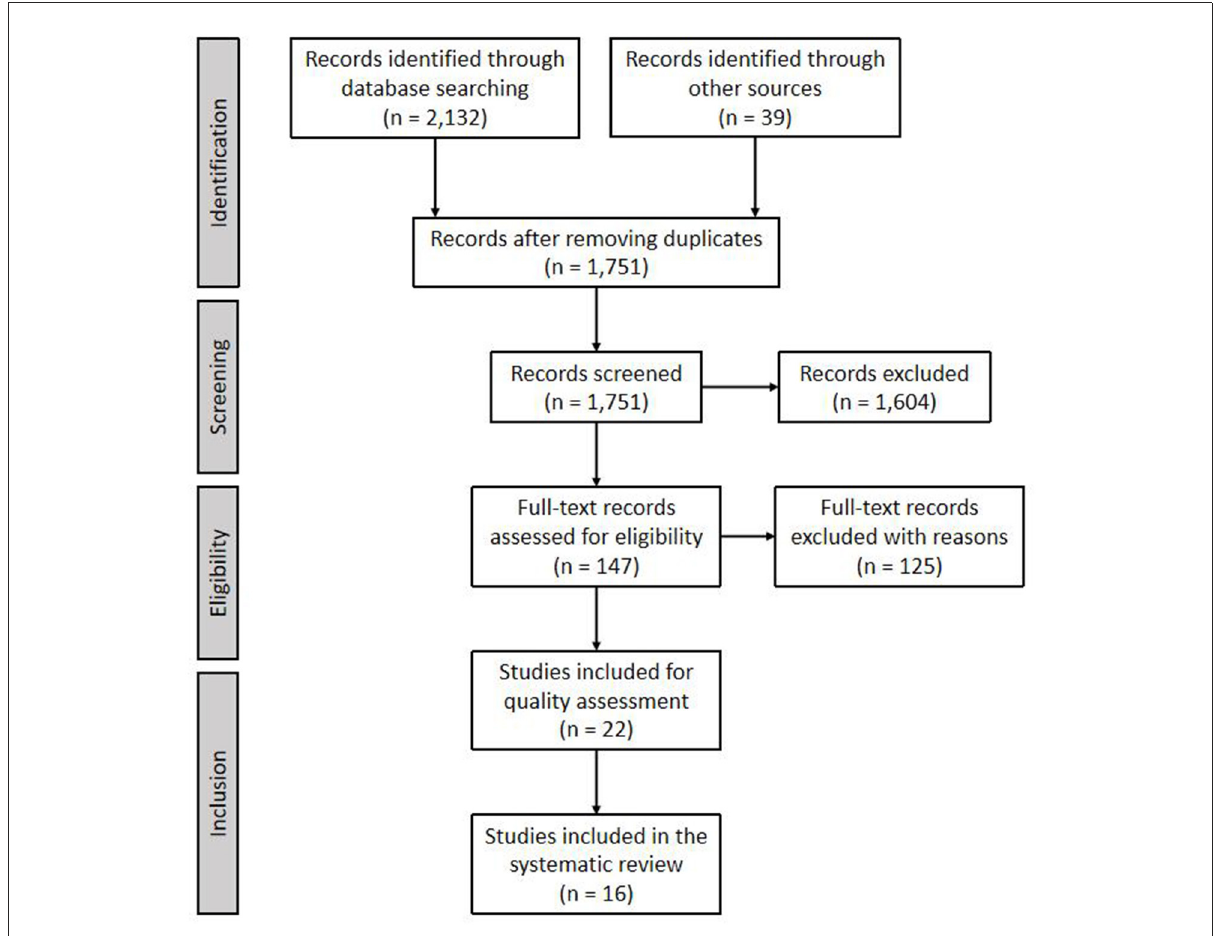
FIGURE1 PRISMA flow